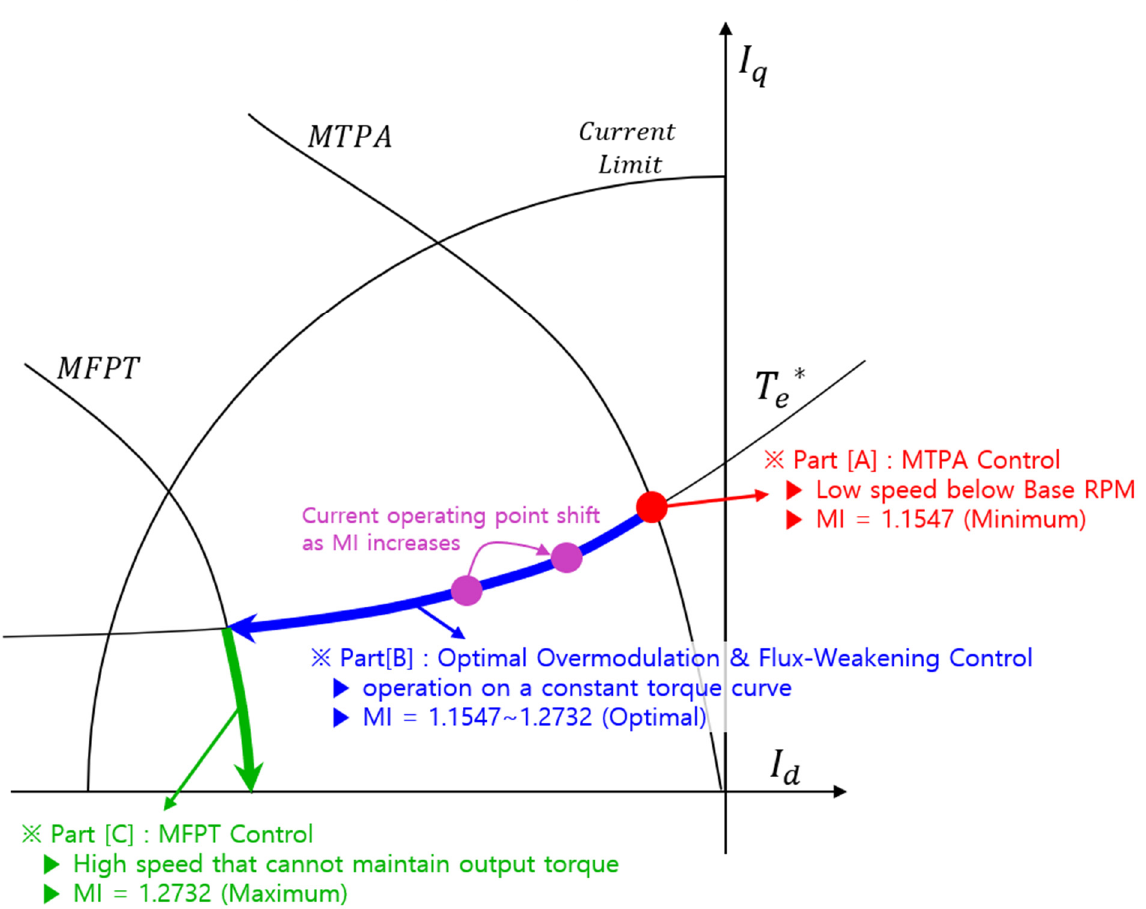
Figure 7. Strategies for obtaining an optimal MI according to speed range.